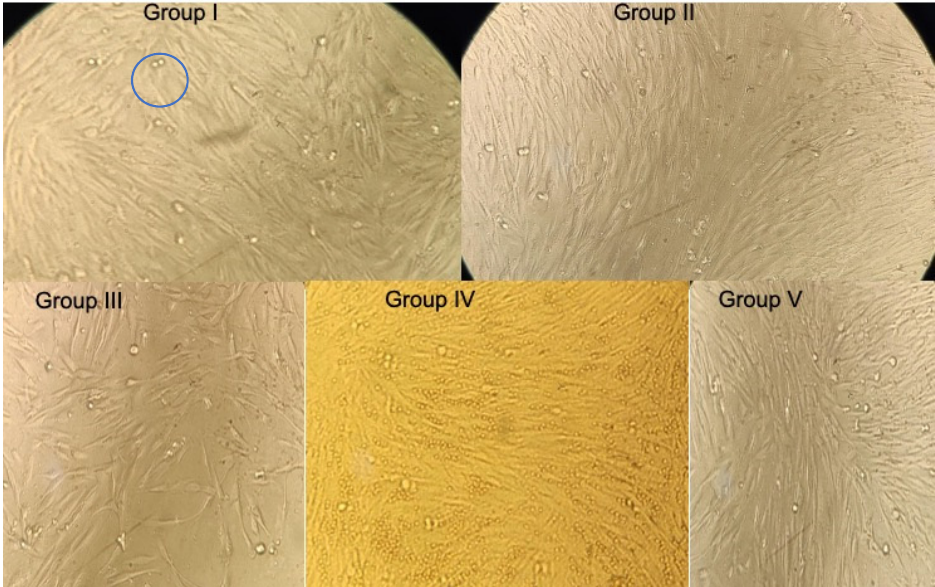
Figure 1. Histological assessment of MTT (3-[4,5-dimethylthiazol-2-yl]-2,5 diphenyl tetrazolium bromide) Assay of hDPSCs (Human Dental Pulp Stem Cells) treated with groups after 24 h. Circle represents living stem cells in cluster form. Table 2. Comparison of MTT assay results at 24, 48, and 72 h among the groups.